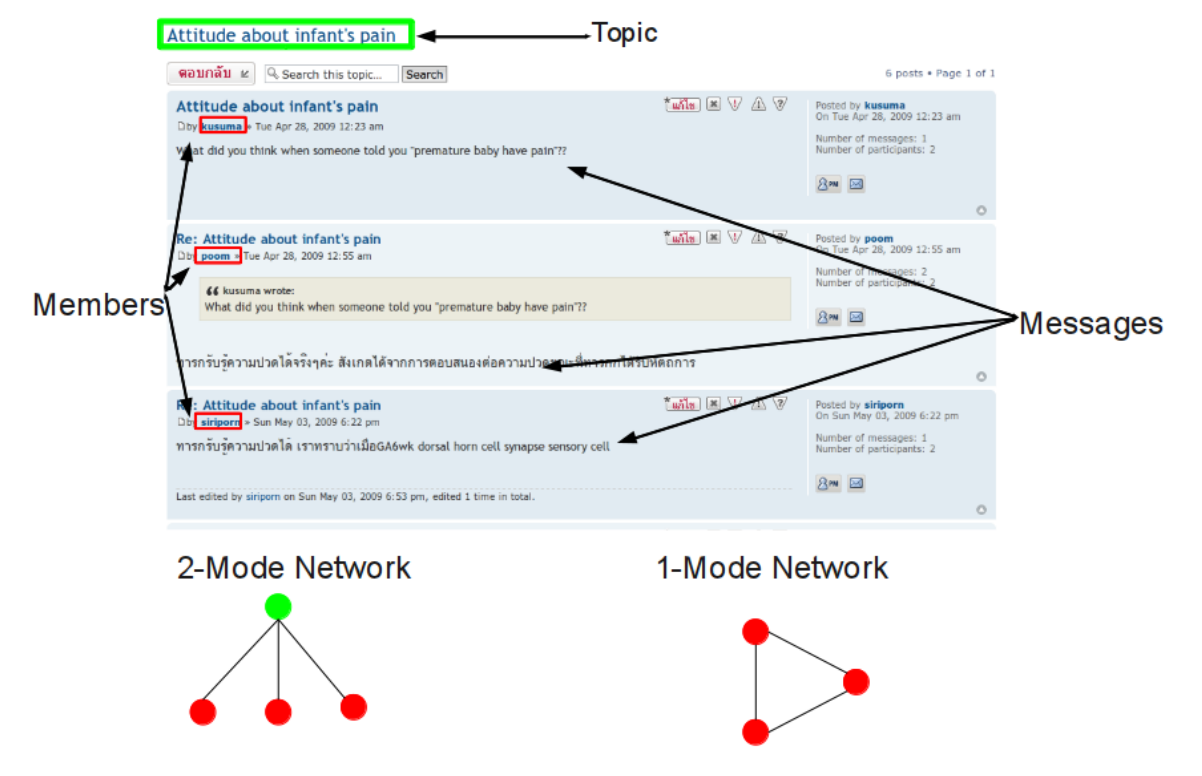
Figure 1. An example thread from the discussion forum, identifying how the threads are presented, where the data is extracted from, and how the 1- and 2-mode networks are created.